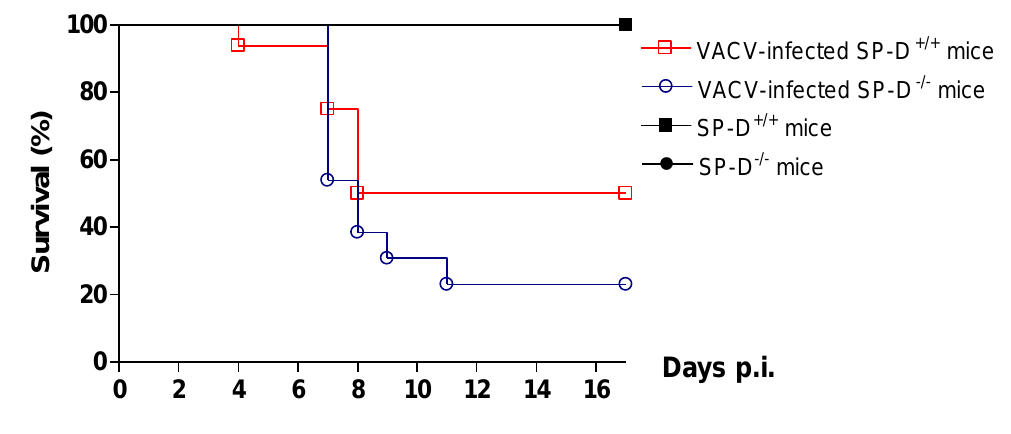
Figure 6. SP-D protected mice against VACV-WR. Five week old Black Swiss mice SP- D +/+ and SP-D -/- were infected intranasally with 1 LD monitored for 17 days. SP-D -/- group was compared to SP-D +/+ group and to a mock- infected group (Log Rank